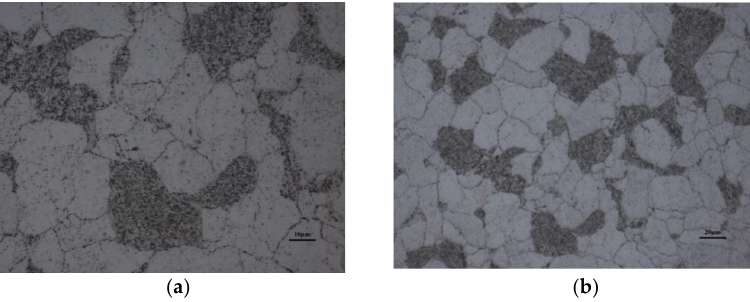
Figure 4. Metallographic structure of external surface in the 270° direction. ( a ) 500×, ( b ) 1000×.